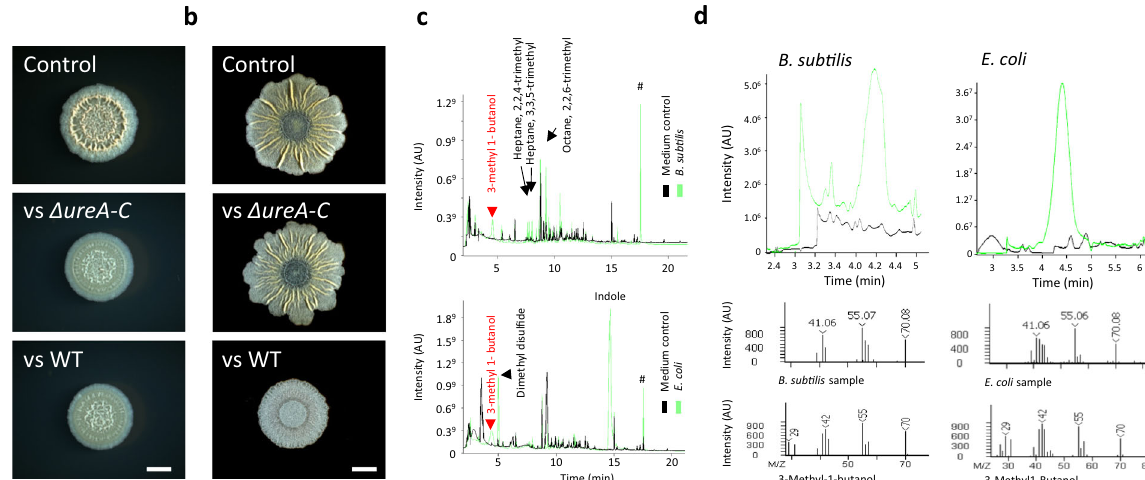
Fig. 4 3-methyl-1-butanol is commonly produced by B. subtilis and E. coli bio fi lms to inhibit bio fi lm formation. a B. subtilis 3610 bio fi lm colonies grown on solid B4 medium either alone, or in the presence of 30 neighbouring colonies (either WT or Δ ureA-C , as indicated). Colonies were incubated for 2 days at 30 °C. Images are representative of ( n > 3) independent experiments. b Experiment was performed as in a on MSgg medium. c Total ion chromatogram pro fi les of B. subtilis and EPEC volatiles produced by its bio fi lm as judged by GC – MS. Headspace analysis of a medium control is in black, and of a bio fi lm colony in green. Peaks were cross-referenced with National Institute of Standards and Technology (NIST) and Wiley libraries. d Representative Selected mass (55.07 Da) chromatogram of 3-methyl-butanol of the produced by B. subtilis (on MSgg) and E. coli (on LBNS). Headspace analysis of a medium control is in black, and of a bio fi lm colony in green. MS spectra of the standard (3-methyl-1-butanol) and peak identi fi ed as 3-methyl-1-butanol in B. subtilis (on MSgg) and E. coli (on LBNS) is provided. Experiments were performed with three independent repeats and four technical repeats.